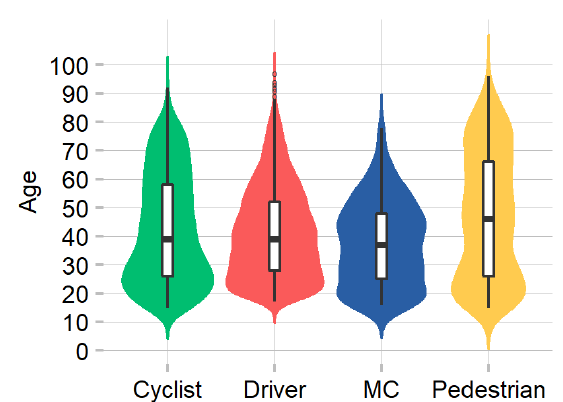
Figure 2. Age distribution for road users. MC: motorcyclist. A boxplot (depicting the median as a solid line, Q1-Q3 as box whiskers up to 1.5 times the interquartile range, and potential outliers as points) is embedded in a violin plot (a visualization of the kernel density estimate, a smoothed version of the